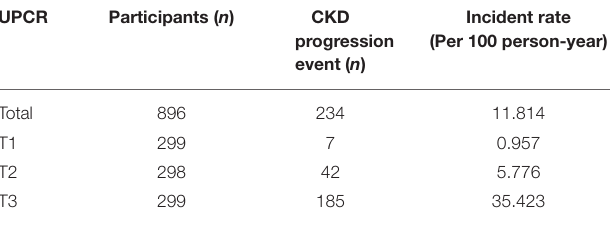
TABLE 2 | Incident rate of incident CKD